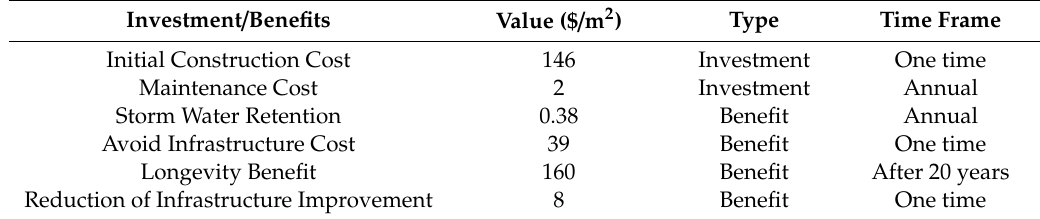
Table 6. Key parameters for the social-economic benefit analysis of installing green roofs [44].